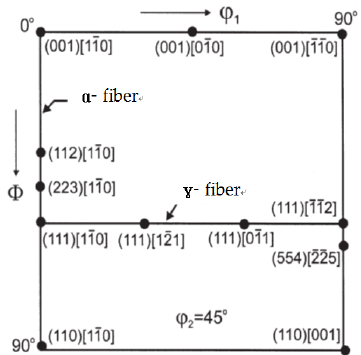
Figure 7. Main texture components of cold- rolled low carbon steels in the φ 2 = 45° section of the orientation distribution functions (ODF) [19].